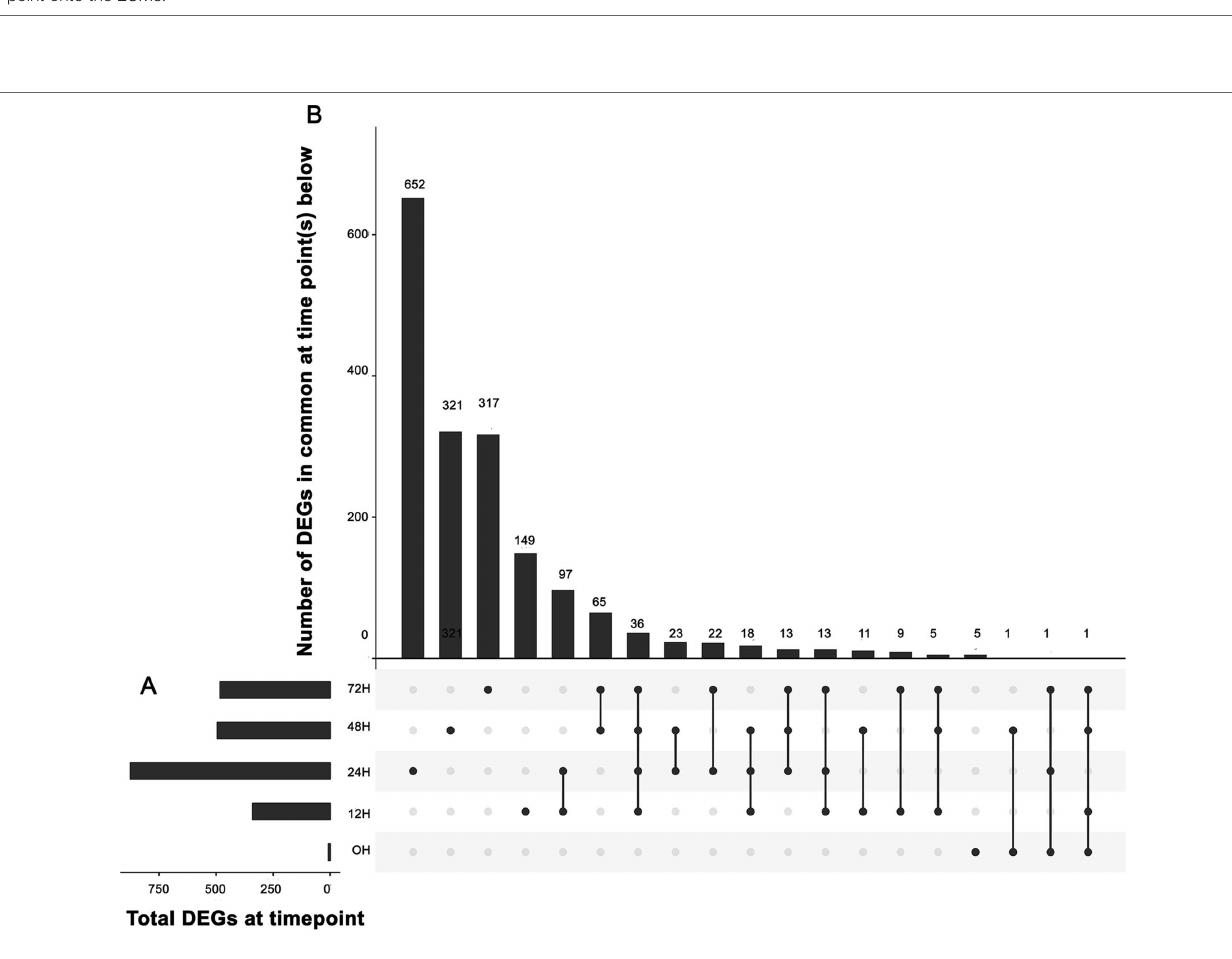
FIGURE 1 | Experimental overview. (A) Differentially expressed genes between control and inoculated samples were identified at each time point. Elongated triangles represent roots; colored portions are the areas harvested (see Methods ) for each comparison in the bracket at the bottom. (B) A gene co-expression network was constructed from all 30 samples (see Methods ) and (C) link community modules were identified by Knowledge Independent Network Construction. Differentially expressed link community modules (LCMs) were then identified by overlaying differentially expressed genes (yellow dots in modules) from each time point onto the LCMs.